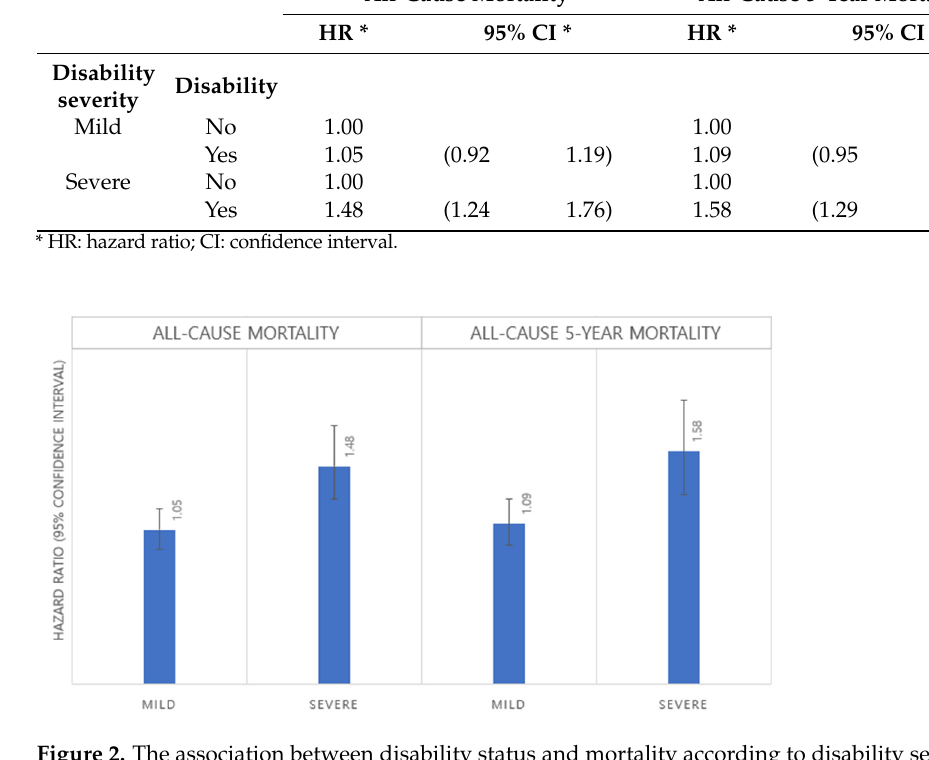
Figure 2. The association between disability status and mortality according to disability severity.